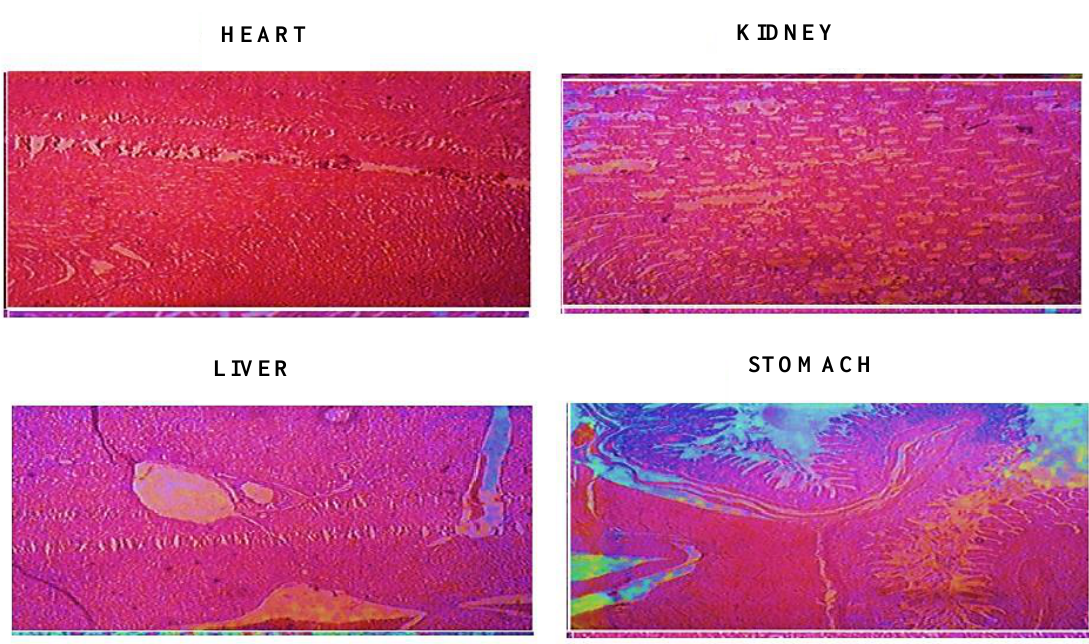
Figure 10. Histopathological micrographs, showing the effect of nanosponges on the cells of epithelial origin of vital organs.